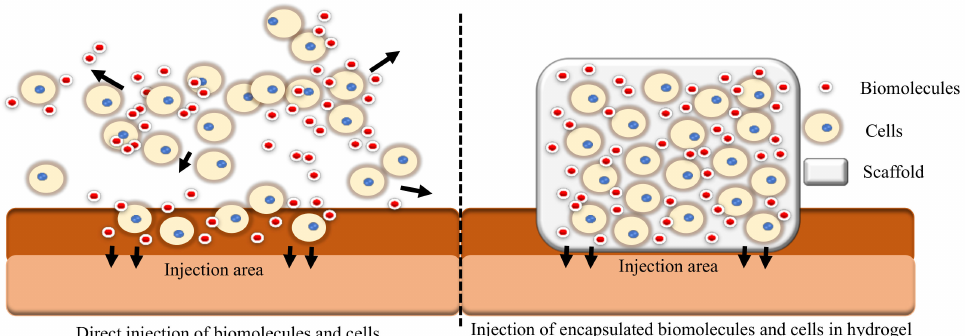
Figure 3. A comparison between direct injection of cells and biomolecules versus injection of cells and biomolecules encapsulated in a hydrogel.